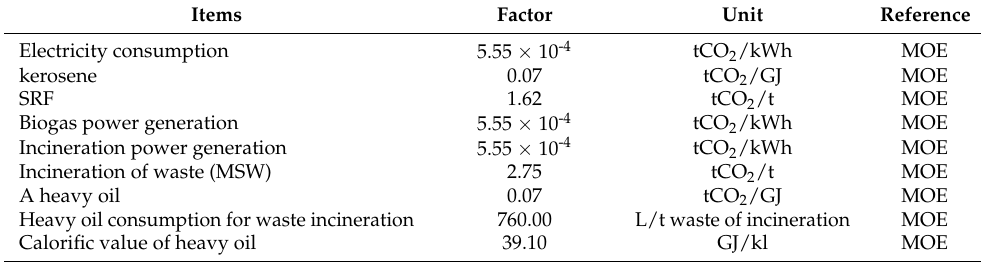
Table 11. GHG Emission factors.